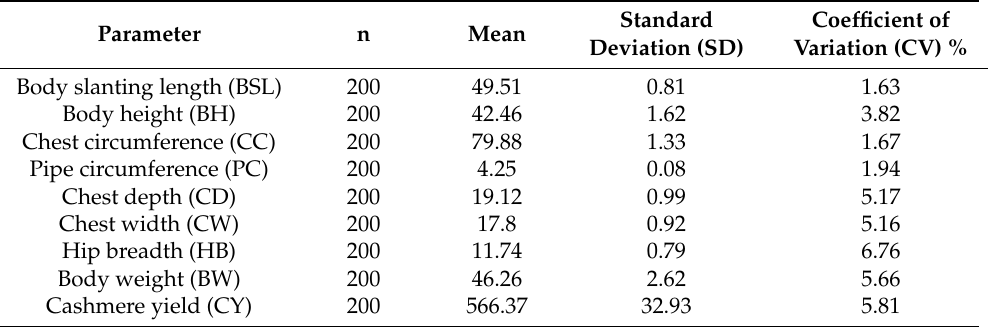
Table 1. Descriptive statistics of certain body measurements, body weight, and cashmere yield of Liaoning cashmere